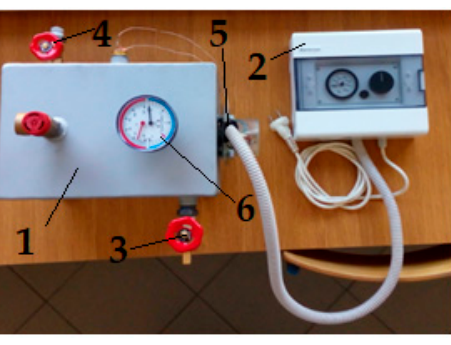
Figure 3. Water steam device used in experimental research: 1—pressurized tank, 2—control system, 3—steam outlet, 4—water inlet, 5—electric heater, 6—pressure and temperature measuring device.